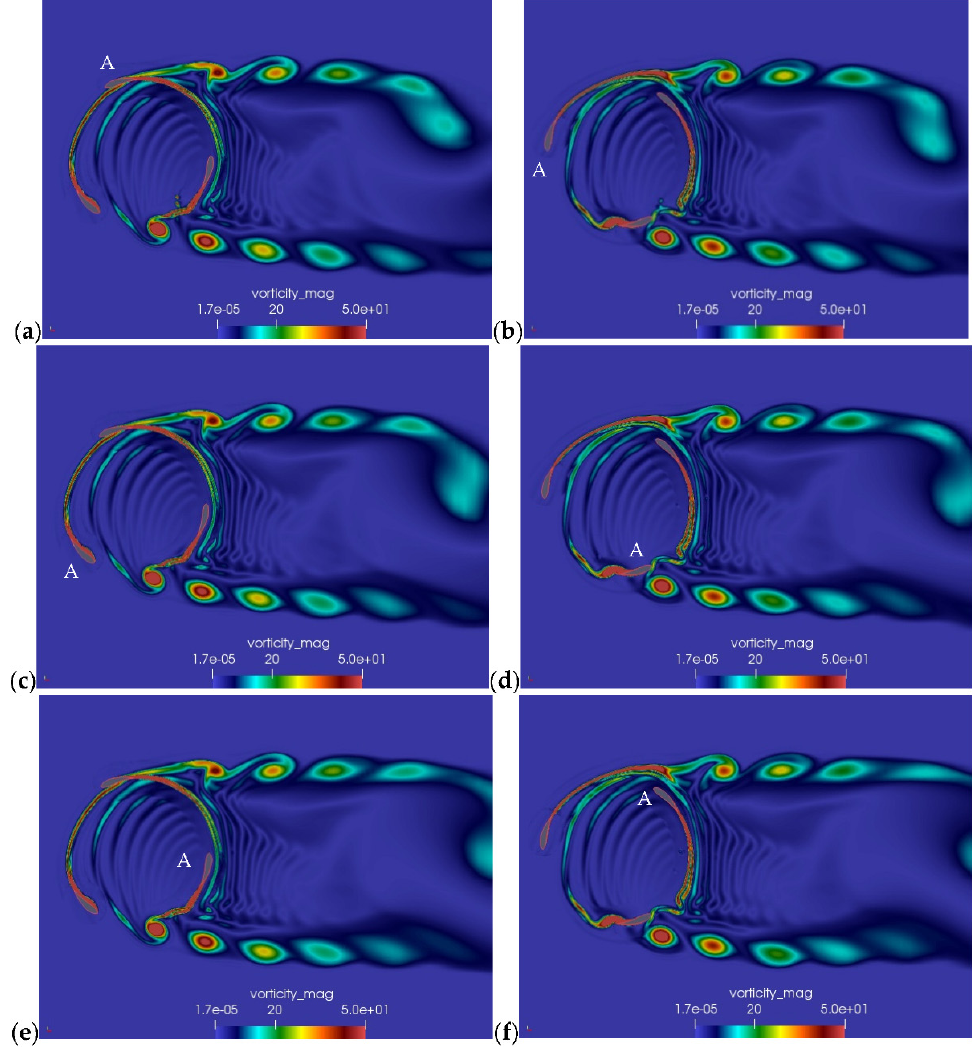
Figure 9. Instantaneous vorticity field for OM at TSR = 2 and different azimuthal angles: ( a ) 15°, ( b ) 75°, ( c ) 135°, ( d ) 195°, ( e ) 255°, ( f ) 315°.